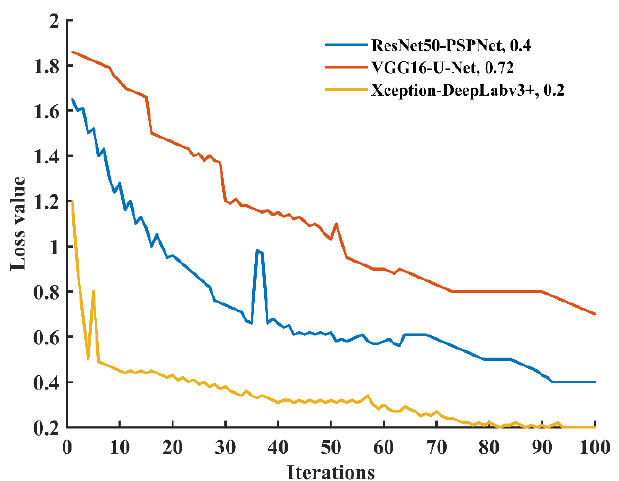
Figure 5. The change in loss value with the number of iterations.